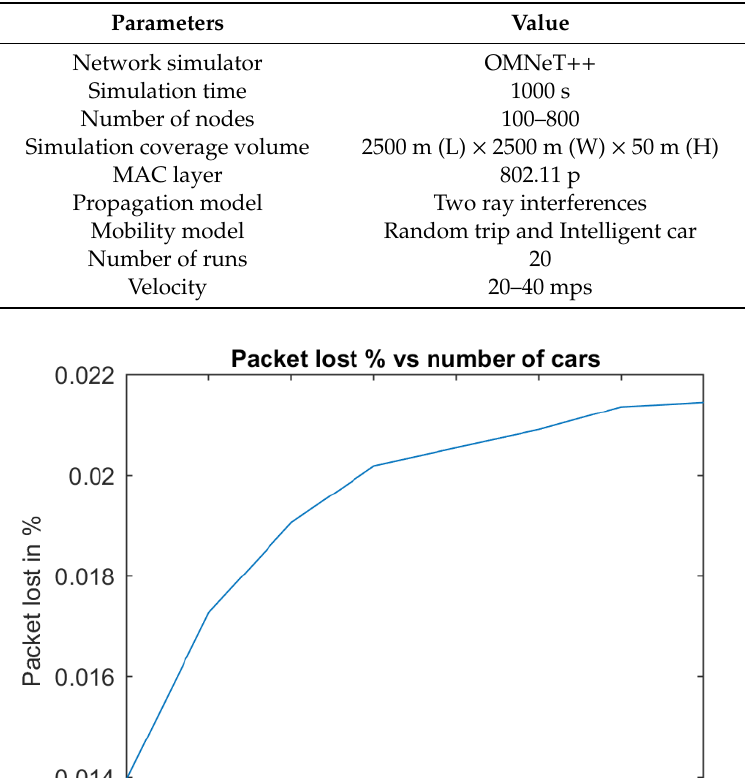
Figure 7. Simulation in OMNeT++. Table 1. Summary of simulation parameters.